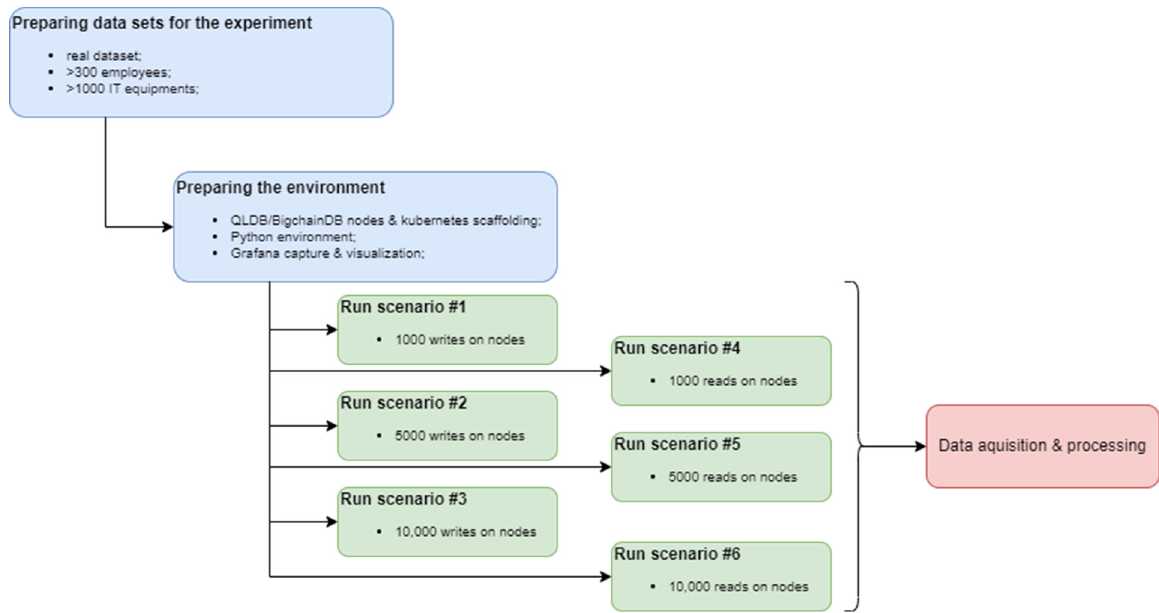
Figure 3. Flow diagram of the experimental evaluation.